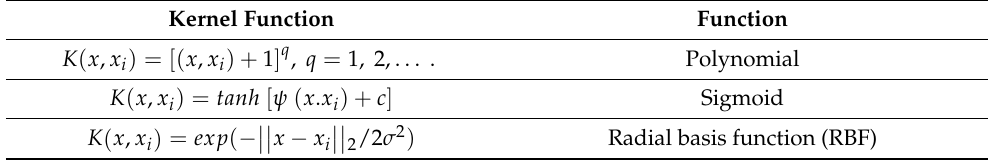
Table 2. Common kernel functions [51].